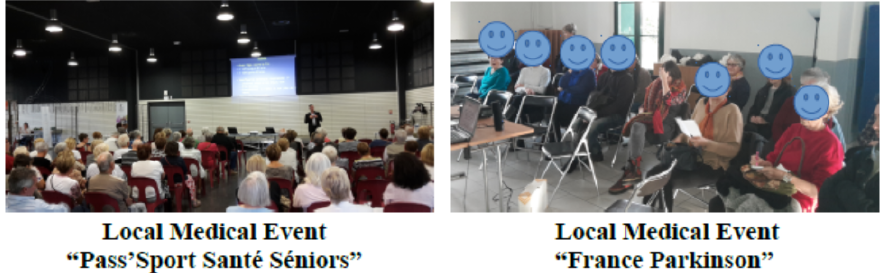
Figure 2. Briefing and involvement sessions.